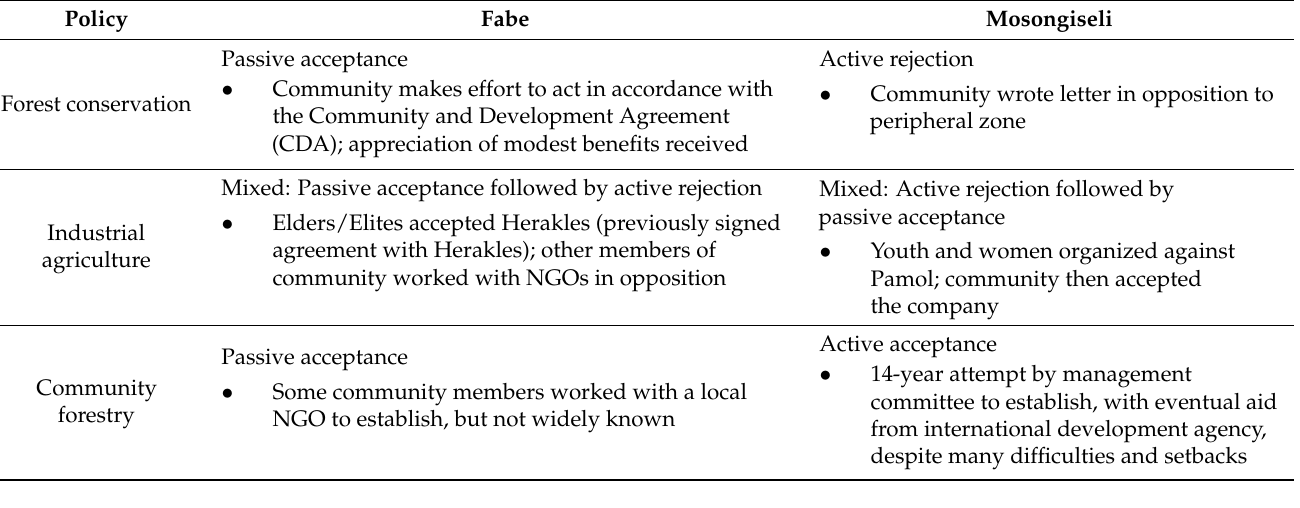
Table 5. Modes of interaction with forest